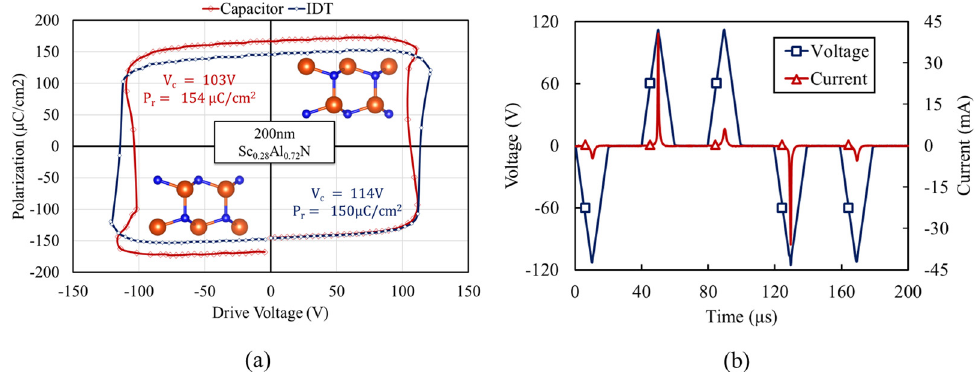
Figure 5. ( a ) Polarization − voltage (P − V) hysteresis loop measured at an IDT port and a 100 µ m × 100 µ m capacitor. ( b ) The measured instantaneous current at the IDT port, upon the application of a 45 kHz triangular PUND pulse sequence, highlighting polarization reversal in Sc 0.28 Al 0.78 N film.